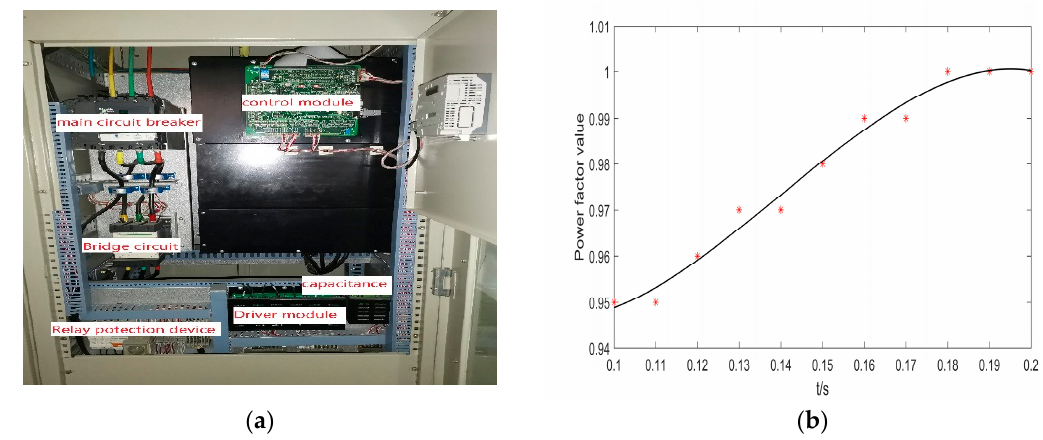
Figure 16. Actual system structure and power factor fitting curve of ( a ) the D-STATCOM system module structure and ( b ) system power factor curve fitting.